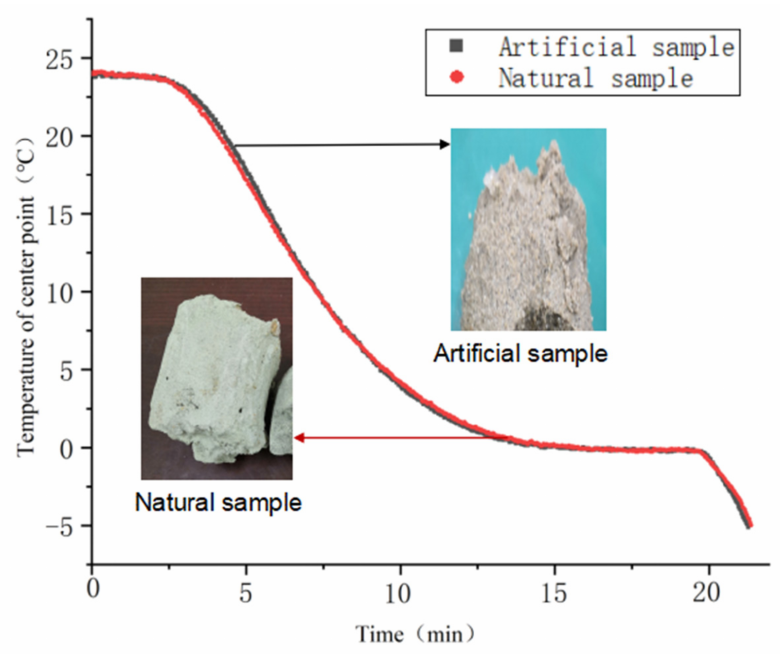
Figure 4. Relationship between the temperature of center point and the freezing time.